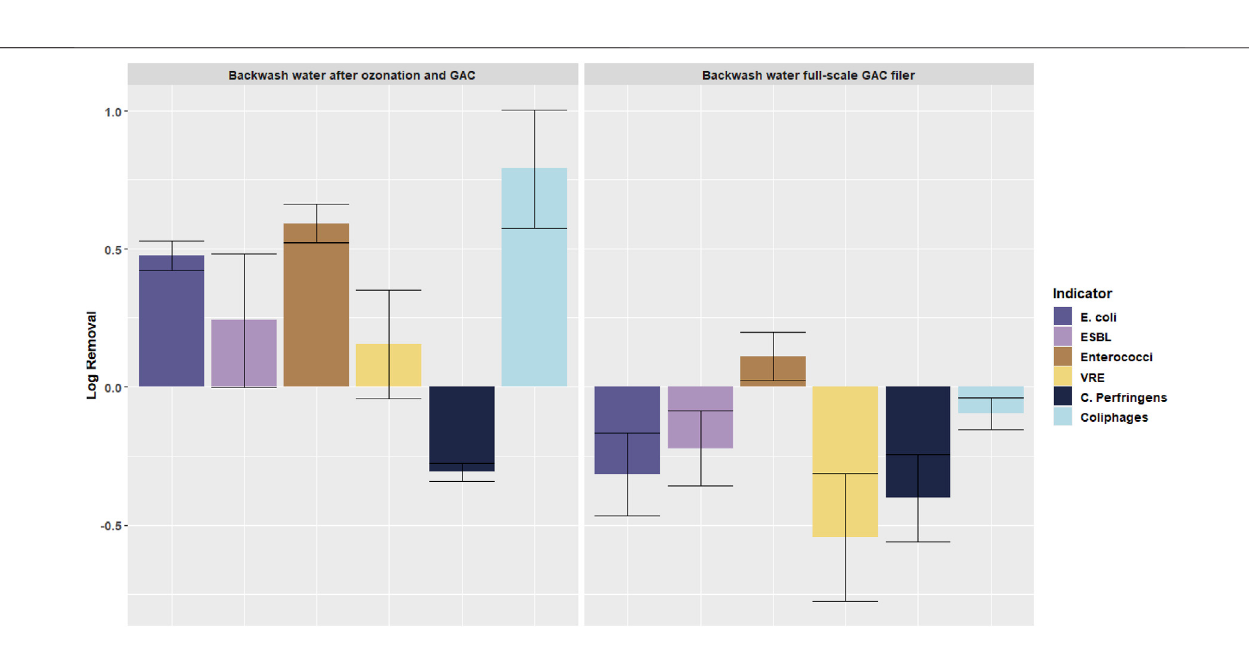
Frontiers in Environmental Science |